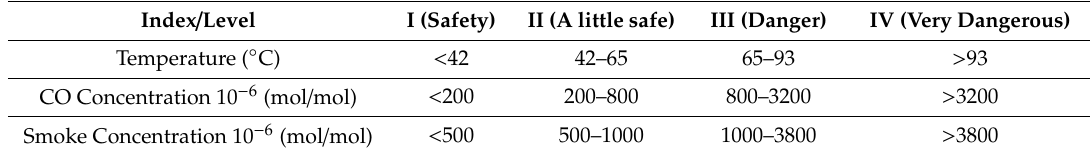
Table 1. Classification standards of fire risk assessment indicators.